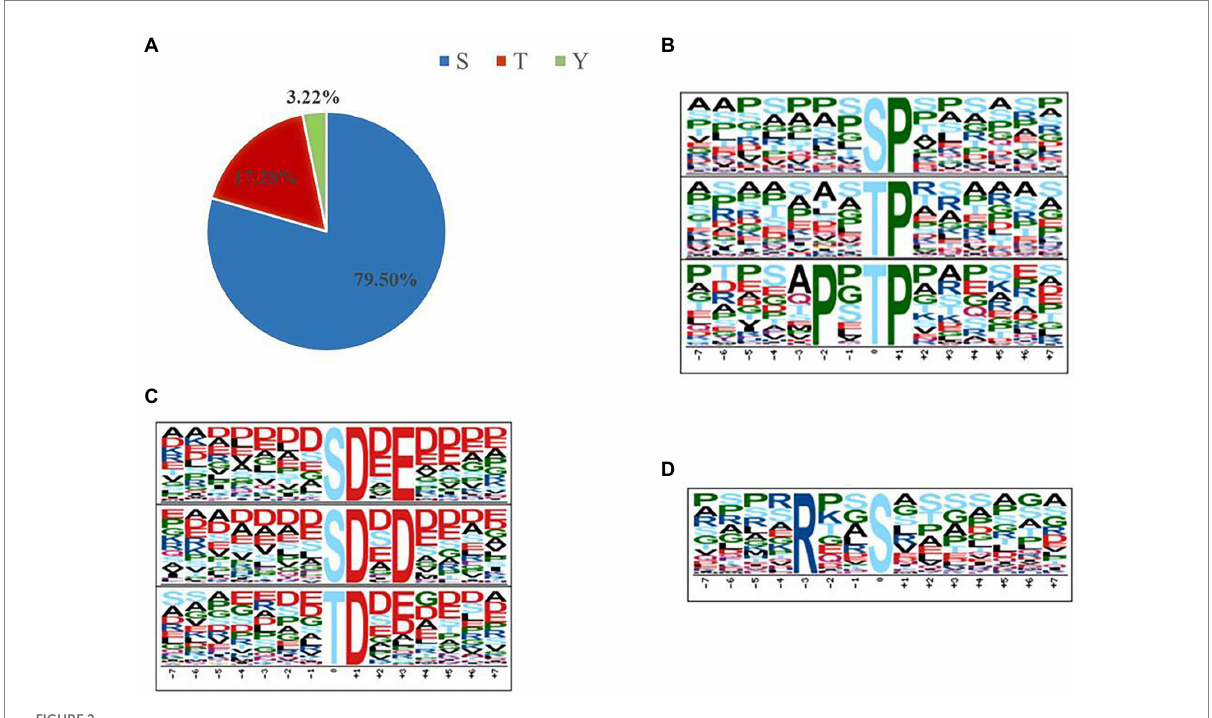
FIGURE 2 Phosphorylation-specific motifs using the Motif-X algorithm (Schwartz and Gygi, 2005). The complete set of motifs is shown in Supplementary Table S5. (A) In total, 5,659 phosphosites (4,499 pSer, 978 pThr, and 182 pTyr) were identified. (B,C) Sequence logos for some examples of single-phosphorylation motifs where the phosphorylated residue (S or T) is centered. (B) Pro-directed motifs. (C) Acidic motifs. (D) Basic motif.